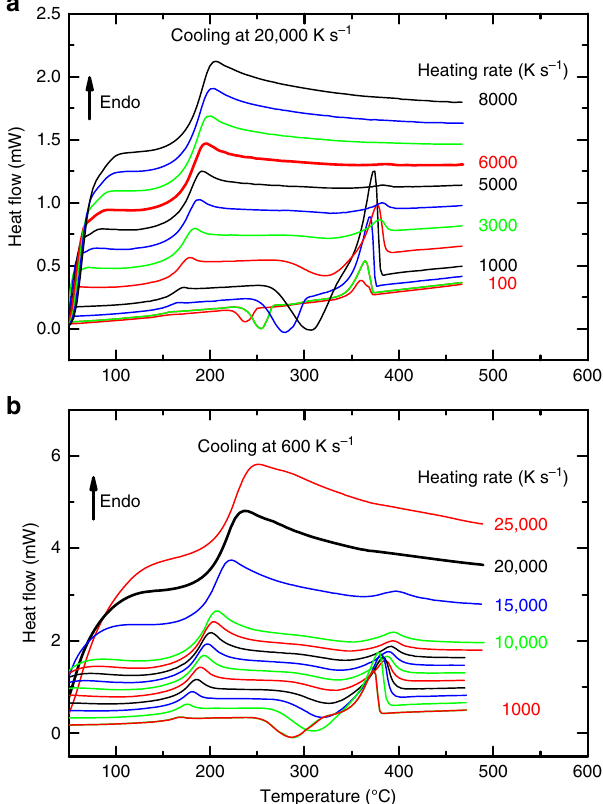
Fig. 3 Heating behavior of CHG and SDG. Selected heating curves measured at various rates, as indicated in the fi gure. a Chemically homogeneous glass (CHG) that was formed at a cooling rate of 20,000 K s − 1 . b Self-doped glass (SDG) that was formed at a cooling rate of 600K s − 1 . The curves measured at the critical heating rates (6000K s − 1 for CHG in a and 20,000Ks − 1 for SDG in b ) are illustrated as bold